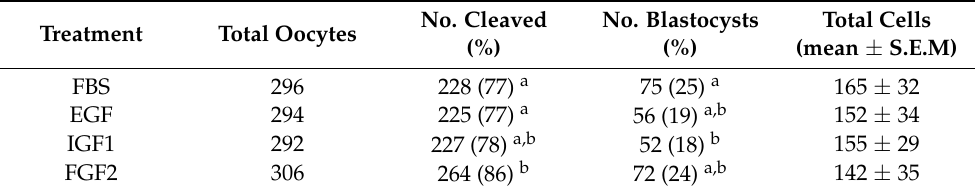
Table 4. Effect of EGF, IGF1 and FGF2 in defined IVP system (in vitro maturation and embryo culture) on developmental potential and total number of cells of bovine